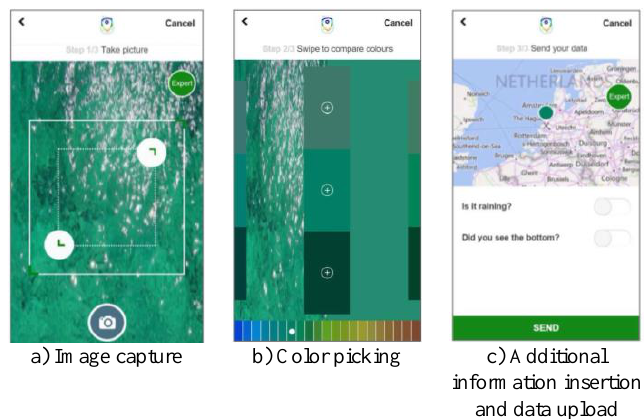
Figure 4: The workflow of EyeOnWater application